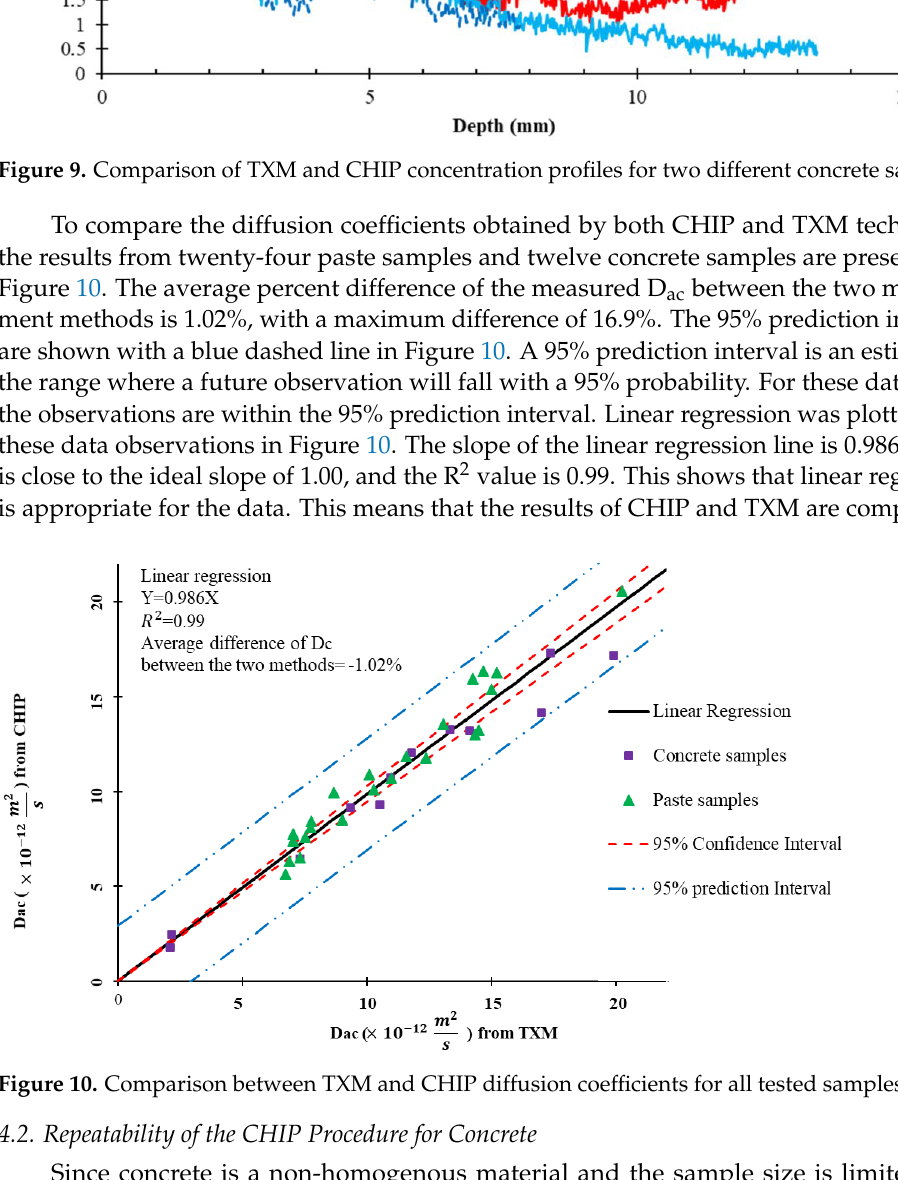
Figure 9. Comparison of TXM and CHIP concentration profiles for two different concrete samples.